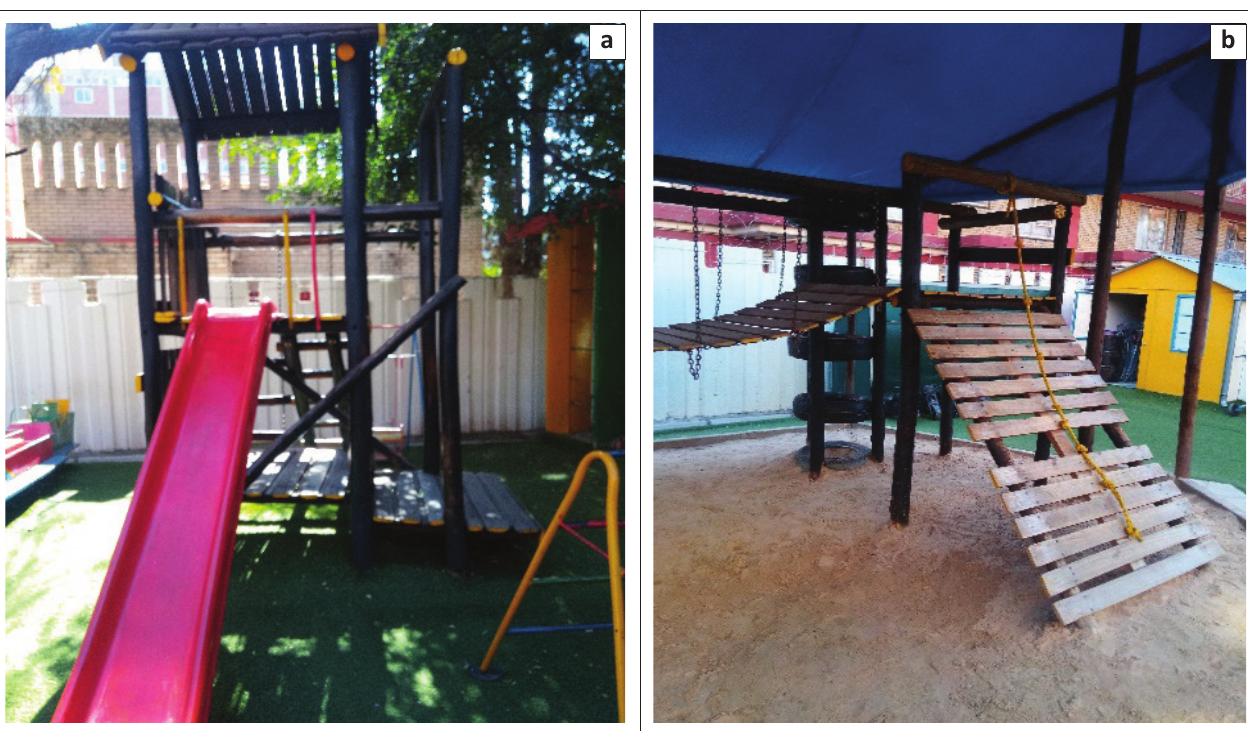
FIGURE 5: Photos (a-b) of suburban centre C’s outdoor play